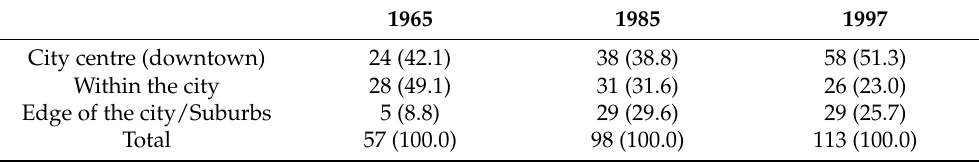
Table 1. Changes in the locations of the home stadiums of the teams in the four most important North American sports (NBA, NHL, MLB, NFL) between 1965 and 1997 (with percentages in brackets). 1965 1985 1997